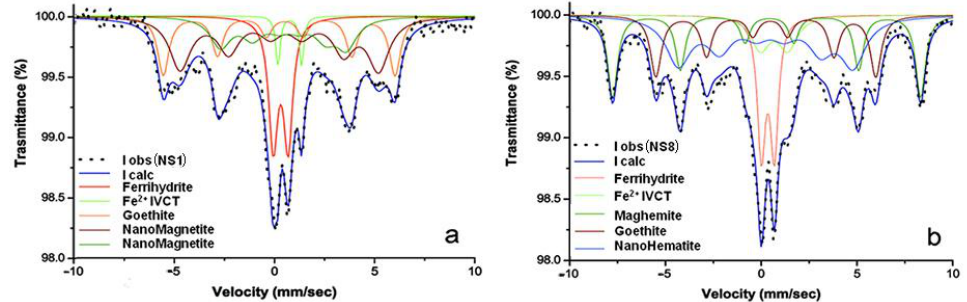
Figure 9. Mössbauer spectra of the historical marble samples: ( a ) NS1; ( b ) NS8. Observed absorption intensity (I obs, black dots) and calculated total intensity (I calc, continuous blue line) are plotted together with calculated absorption components (see text).